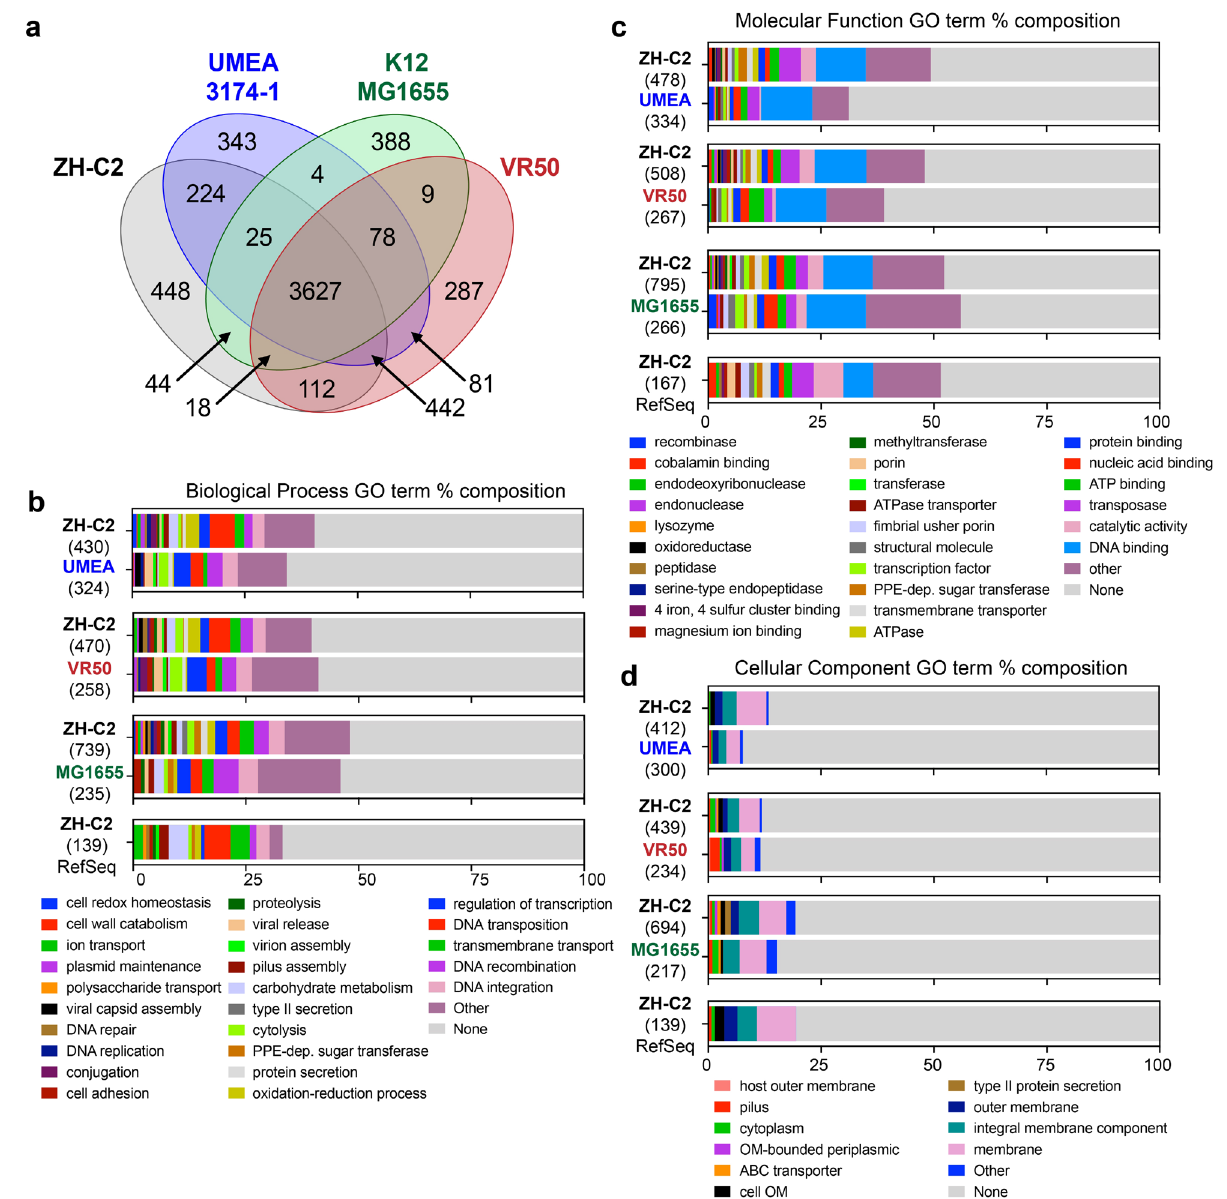
Figure 6. Comparison of encoded E. coli ZH-C2 genes to reference non-pathogenic and pathogenic E. coli . Venn diagram of CD-HIT analysis depicting conservation and differences of gene products between E. coli strains ZH-C2, K-12 MG1655, UMEA 3174-1, and VR50 ( a ). Protein sequences were clustered at CD-HIT sequence similarity cut-off of 90%. Biological process ( b ), molecular function ( c ), and cellular component ( d ) GO Terms of unique genes (less than 70% coverage and/pr less than 90% identity) found in ZH-2 compared to MG1655, UMEA 3174-1, VR50, and the RefSeq reference genome collection. The number of genes used for each GO term analysis is in parentheses. GO Terms listed as “other” include < 2 genes and are expanded in the Supplementary Table